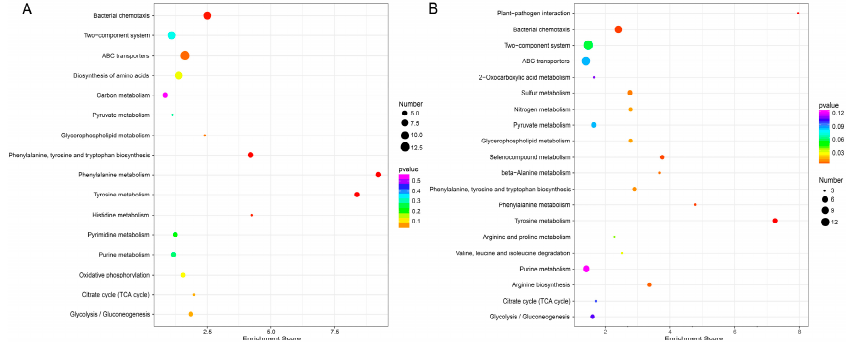
Figure 7. Top 20 DEGs of KEGG pathway enrichment. ( A ) Res 50 vs. Res 0 groups. ( B ) Res 100 vs. Res 0 groups.